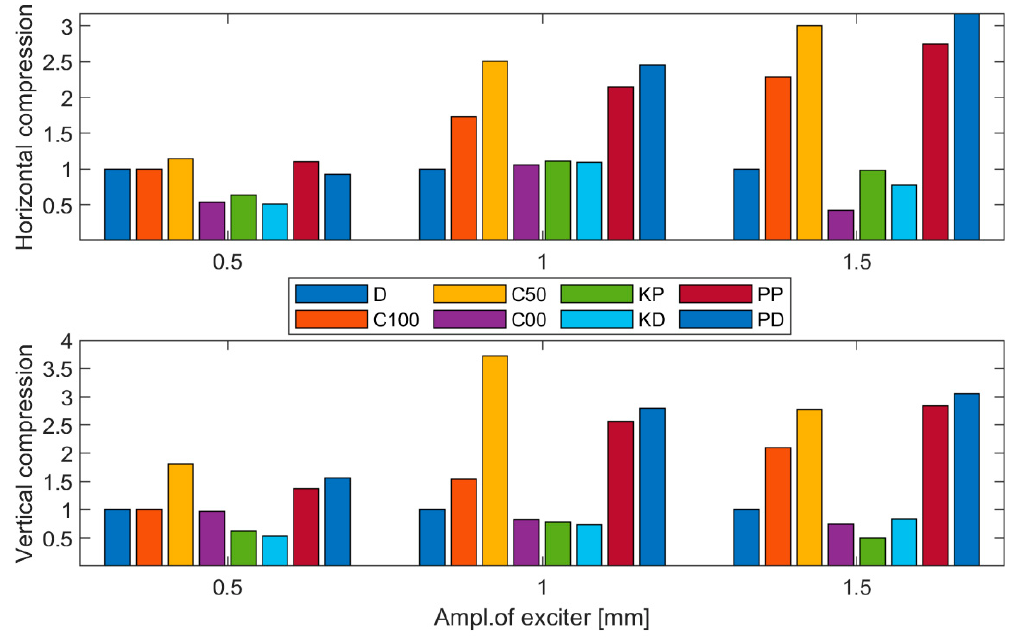
Figure 8. Results of vibration test; the lower the value, the better the